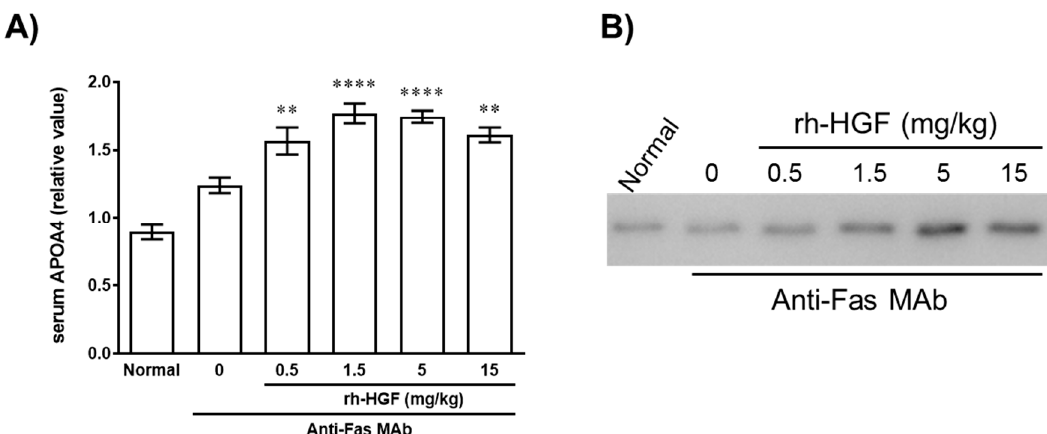
Figure 4. rh-HGF-mediated induction of APOA4 protein in anti-Fas-induced murine ALF model. rh-HGF was injected intravenously one hour prior to the anti-Fas injection. Five hours after anti-Fas administration, the mice were sacrificed and their blood collected for the analyses. ( A ) Relative value of APOA4 protein in serum. PBS was administered in the vehicle control group (rh-HGF, 0 mg/kg). ** p < 0.01, **** p < 0.0001: comparison between the vehicle control- and rh-HGF-treated groups (Dunnett’s test). The data are presented as mean ± SEM ( n = 5–8). ( B ) A representative image of serum APOA4 levels by Western blot. Each lane shows individual animals.